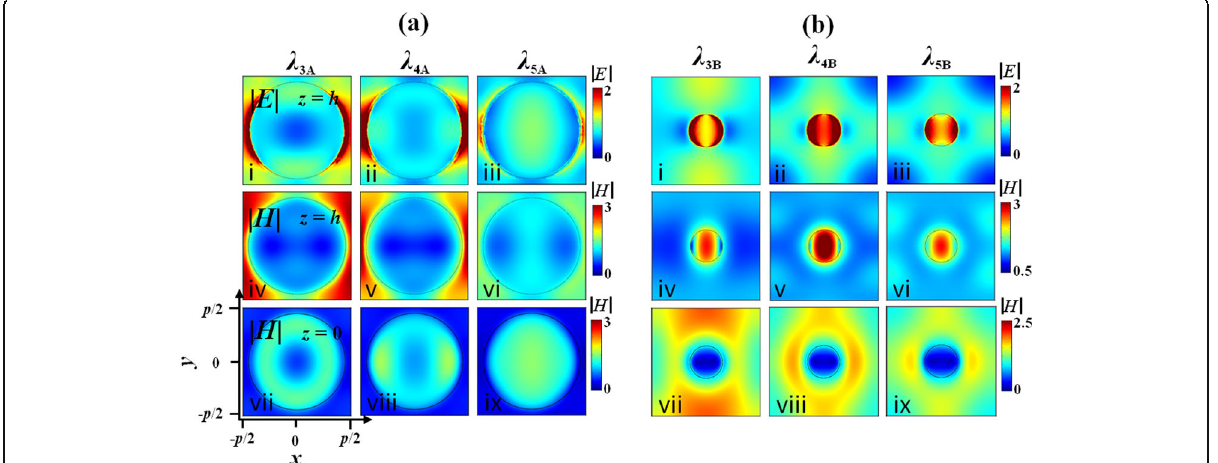
Fig. 6 Field maps under TM polarization at different cross sections at the peaks of λ 3A , λ 4A , and λ 5A ( a ) and λ 3B , λ 4B , and λ 5B ( b ). First row | E | at z = h A or h B , middle row | H | at z = h A or h B , and bottom row | H | at z = 0. The peaks are as labeled in Fig.